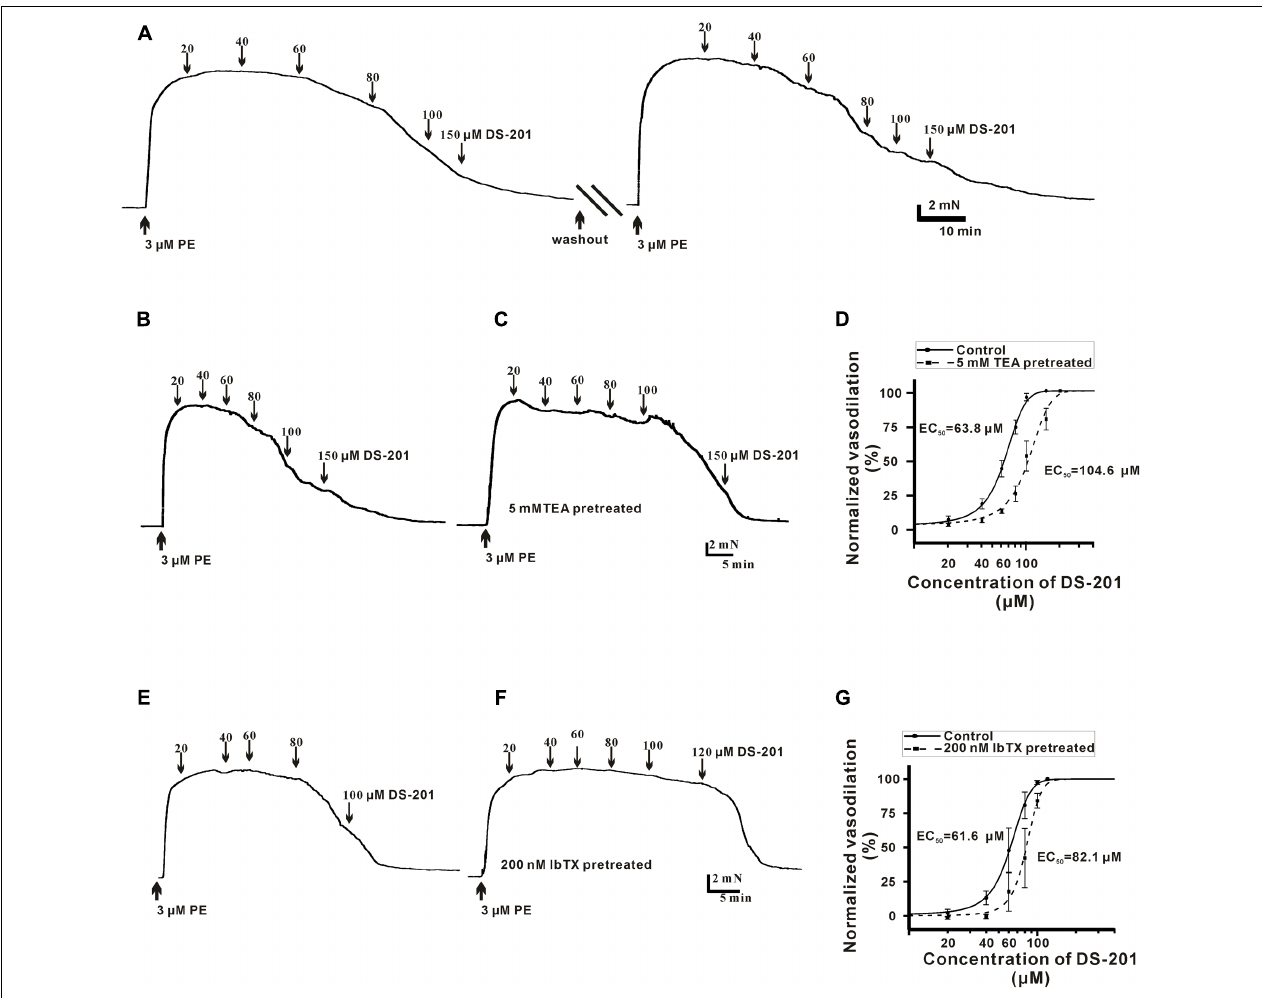
FIGURE 1 | Effect of DS-201 on the vasodilation with or without TEA or IbTX treatment in the PE-preconstricted artery rings. (A) A typical recording shows that DS-201 relaxed the PE-preconstricted artery rings in a concentration-dependent manner and the effect was reversible after 1 h duration of washout and balance. (B) Traces were from one representative artery ring to show the effect of 20–150 µ M DS-201on vasorelaxation. (C) TEA (5 mM) treatment reduced the vasodilation of DS-201in a representative PE-preconstricted artery ring. (D) Concentration–response curves fitted with Hill function showed that TEA (5 mM) shifted the curve rightward. The data were obtained with seven artery rings from six rats for each group. Hill function: Inhibition % = X n /( k n + X n ), X as the concentration of DS-201, K as the Michaelis constant (i.e., EC50), and n as the Cooperative sites. (E) A typical recording shows that DS-201 relaxed the representative PE-preconstricted artery ring in a concentration-dependent manner. (F) IbTX (200 nM) reduced the vasodilation of DS-201in a representative PE-preconstricted artery ring and (G) Concentration -response curves fitted with Hill function and the data show that IbTX shifted the curve rightward. The data were obtained with four artery rings from four rats for each